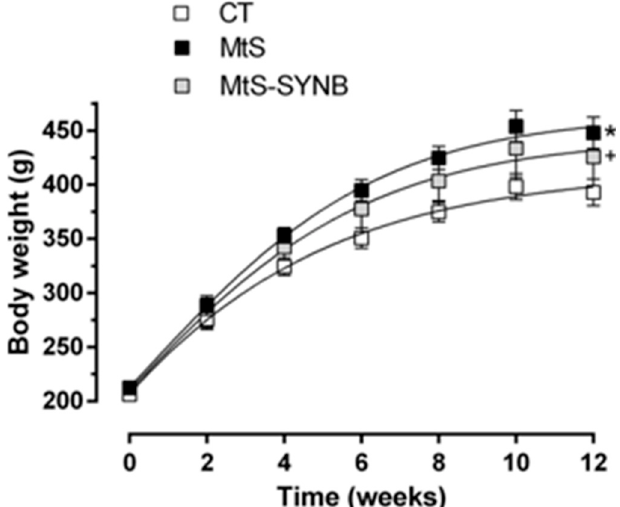
Figure 2. Body weight evolution in CT (control group), MtS (metabolic syndrome) and MtS-SYNB (MtS rats supplemented with Prodefen® Plus ) groups over 12 weeks. Body weight is expressed as mean ± S.E.M. Statistical analysis: Unpaired two-way ANOVA. * p < 0.05 CT vs. MtS; + p < 0.05 CT vs. MtS-SYNB. n = eight animals per group.